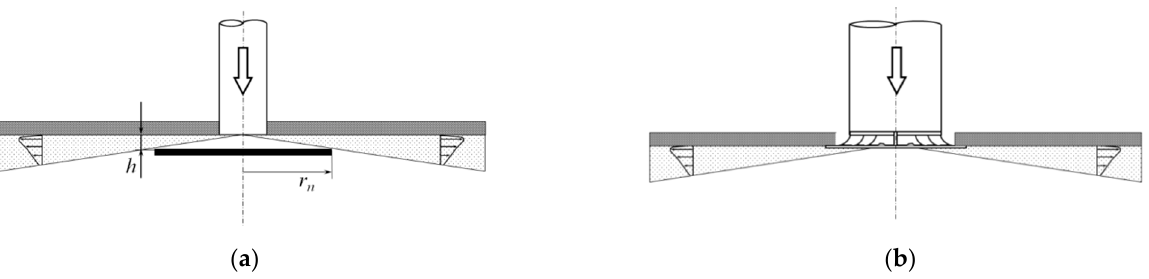
Figure 1. Radial wall jets (RWJs) produced by ( a ) discharging a fluid through the slot between a circular disc and a flat surface and ( b ) issuing the air from the diffuser.